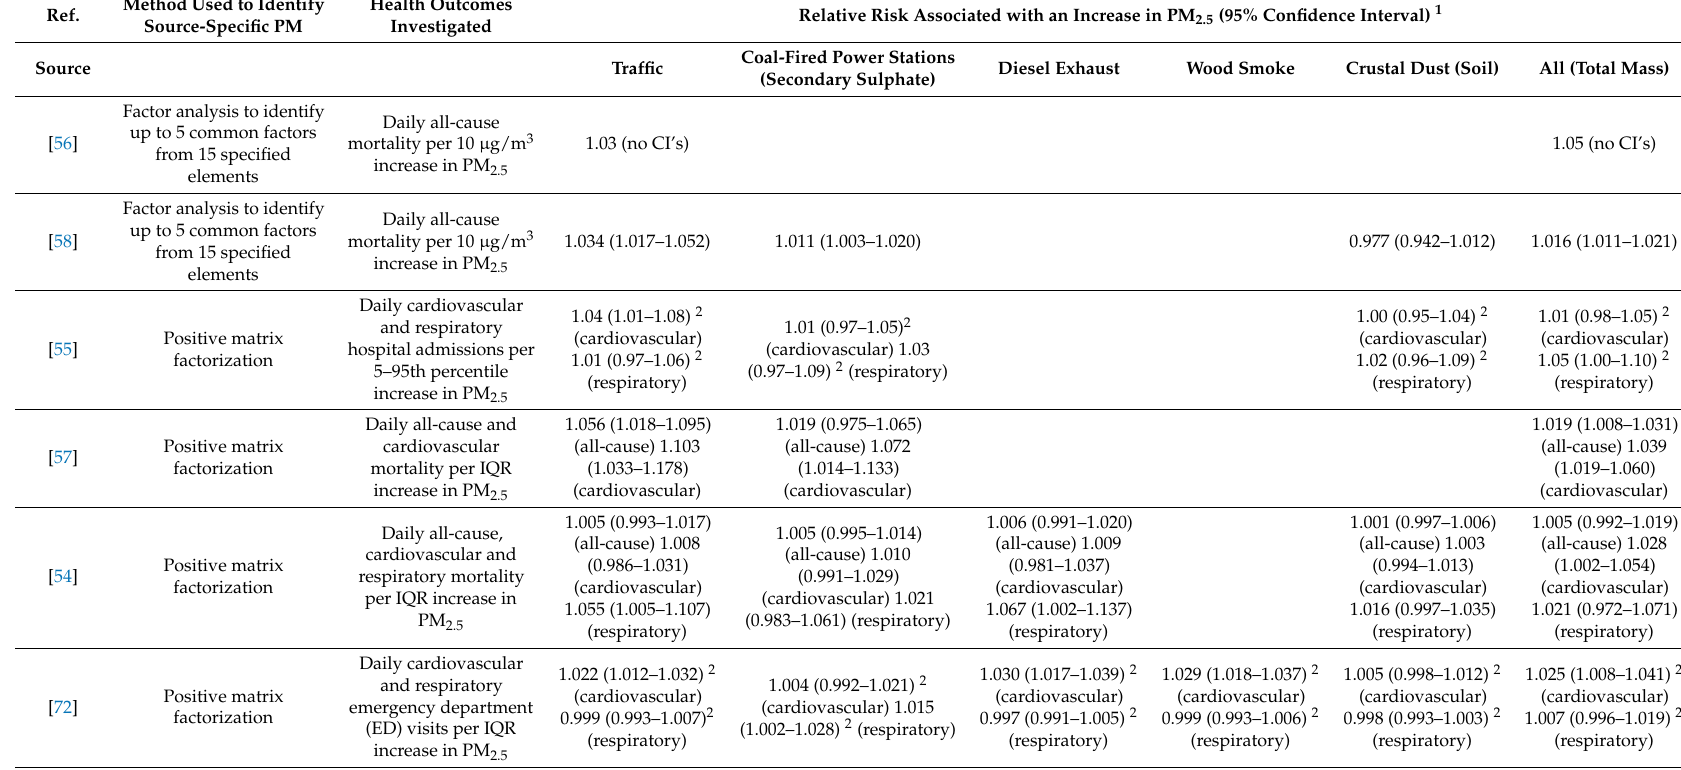
Table 2. Source-apportionment studie s that compared the health effects of different source-specific PM 2.5 within studies.